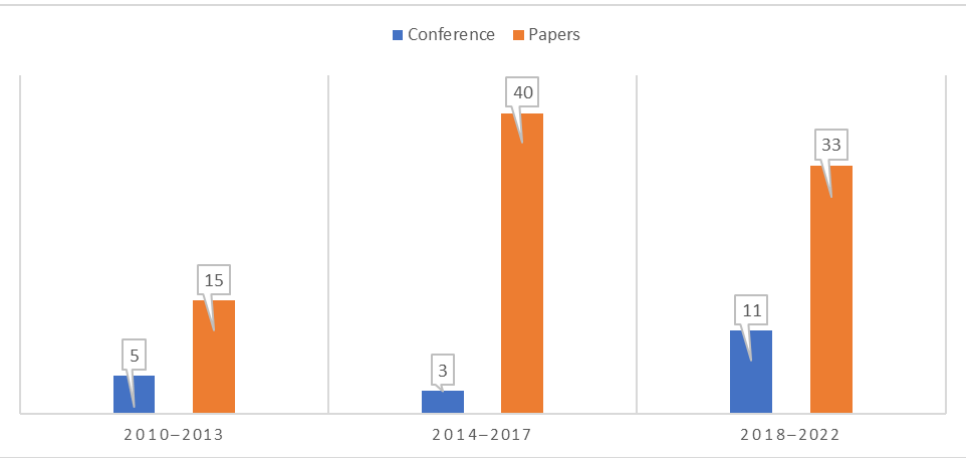
Figure 5. Published scientific articles and conference papers in WoS, Scopus, and Google Scholar databases by period. Source: own processing. databases by period. Source: own